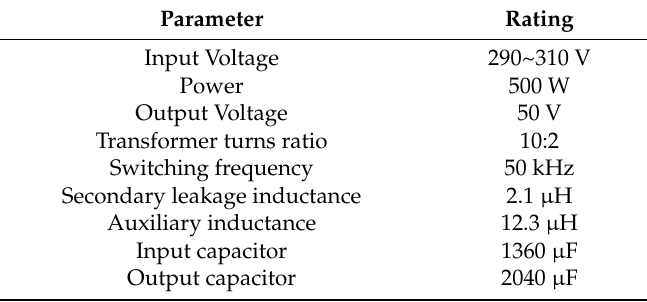
Table 1. DAB-IBDC converter design specifications 500 W.